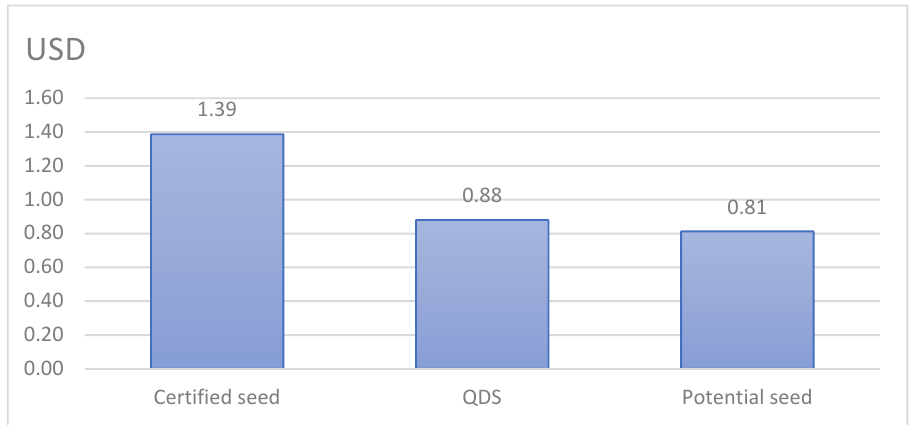
Figure 3. Sales prices for certified seed, QDS, and home-saved seed (grain) for beans. Source: ISSD Program data [43]; exchange rate: 1 USD = 3500 UGX.